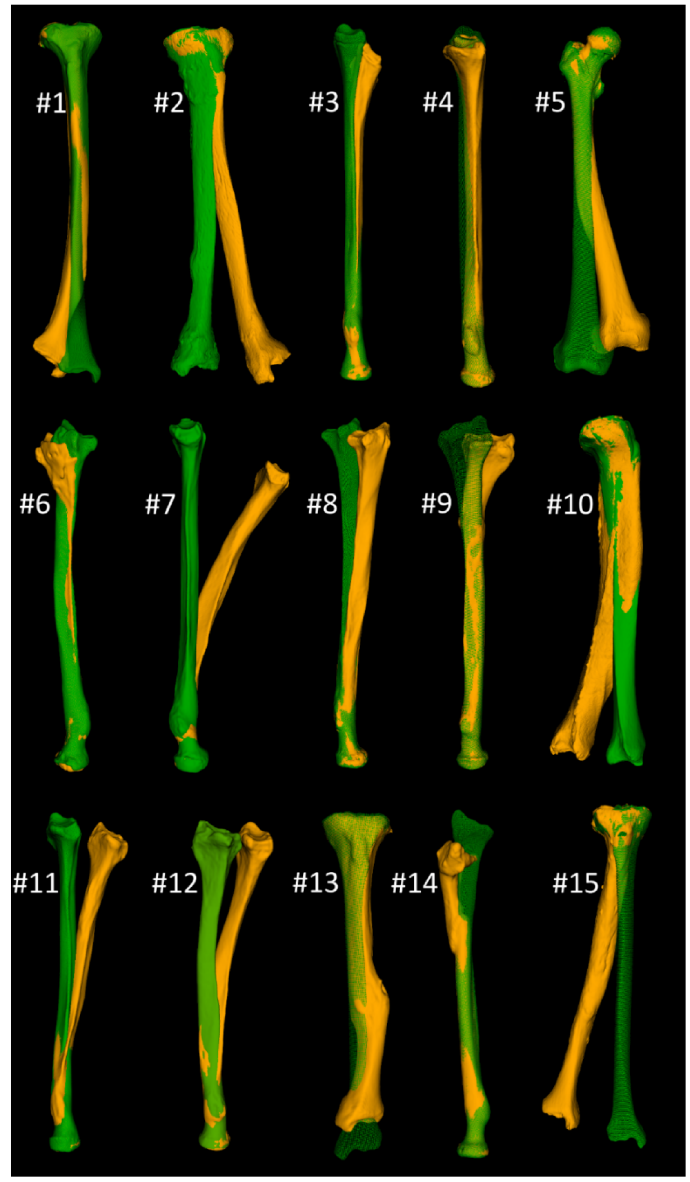
Figure 7. Deformed bone specimens (orange) of the radiuses, tibiae and femur included in this study. The mirrored contralateral bone (green) serves as reconstruction